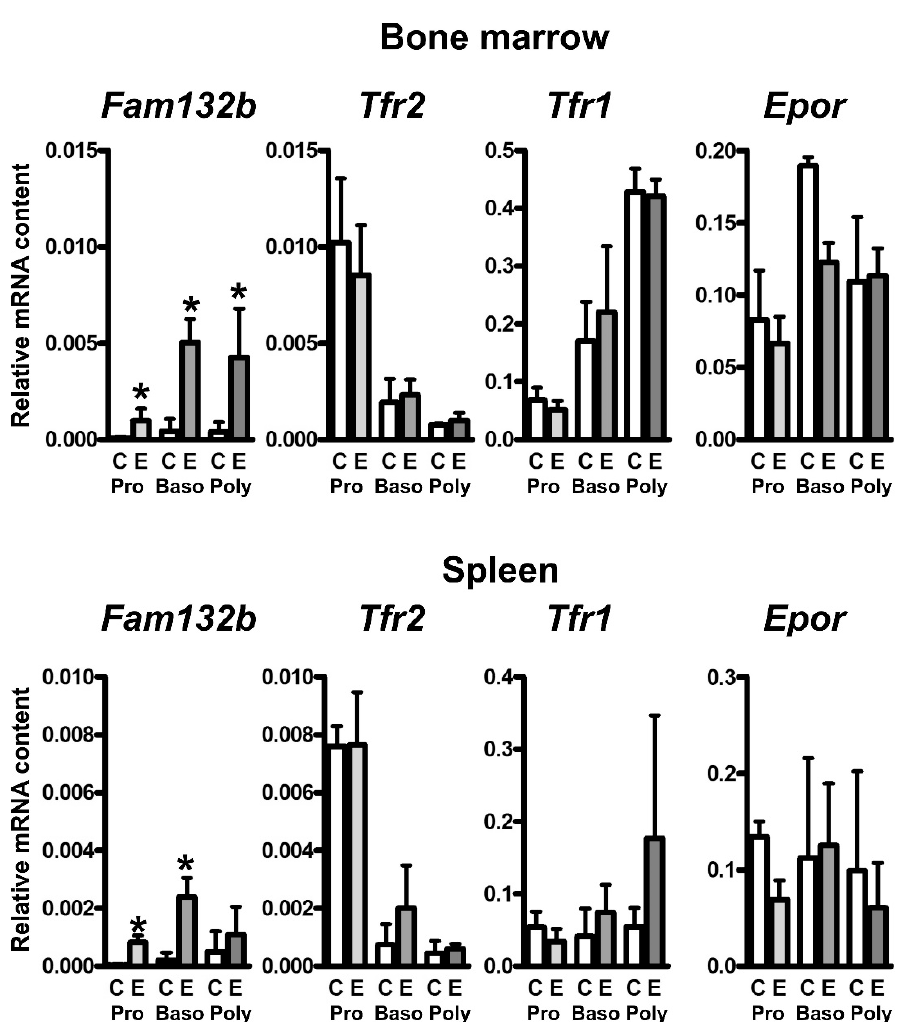
Figure 5. Single injection of EPO increases Fam132b expression in bone marrow and spleen erythroid precursors. EPO was administered at 200 U/mouse; cell populations were obtained 48 h after treat- ment by FACS sorting. C: Expression in control populations, E: expression in EPO-treated populations. Pro: Proerythroblasts; Baso: Basophilic erythroblasts; Poly: Polychromatophilic erythroblasts. Target mRNA content is expressed relative to Actb expression, * denotes statistical significance between EPO-treated group and the respective control group ( p < 0.05). n = 3, values were obtained from three independent experiments.